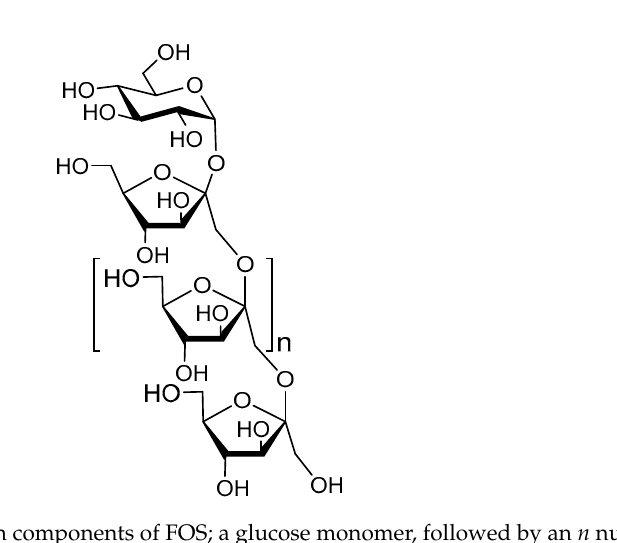
Figure 4. Structure of the main components of FOS; a glucose monomer, followed by an n number of fructose monomers in sequence.